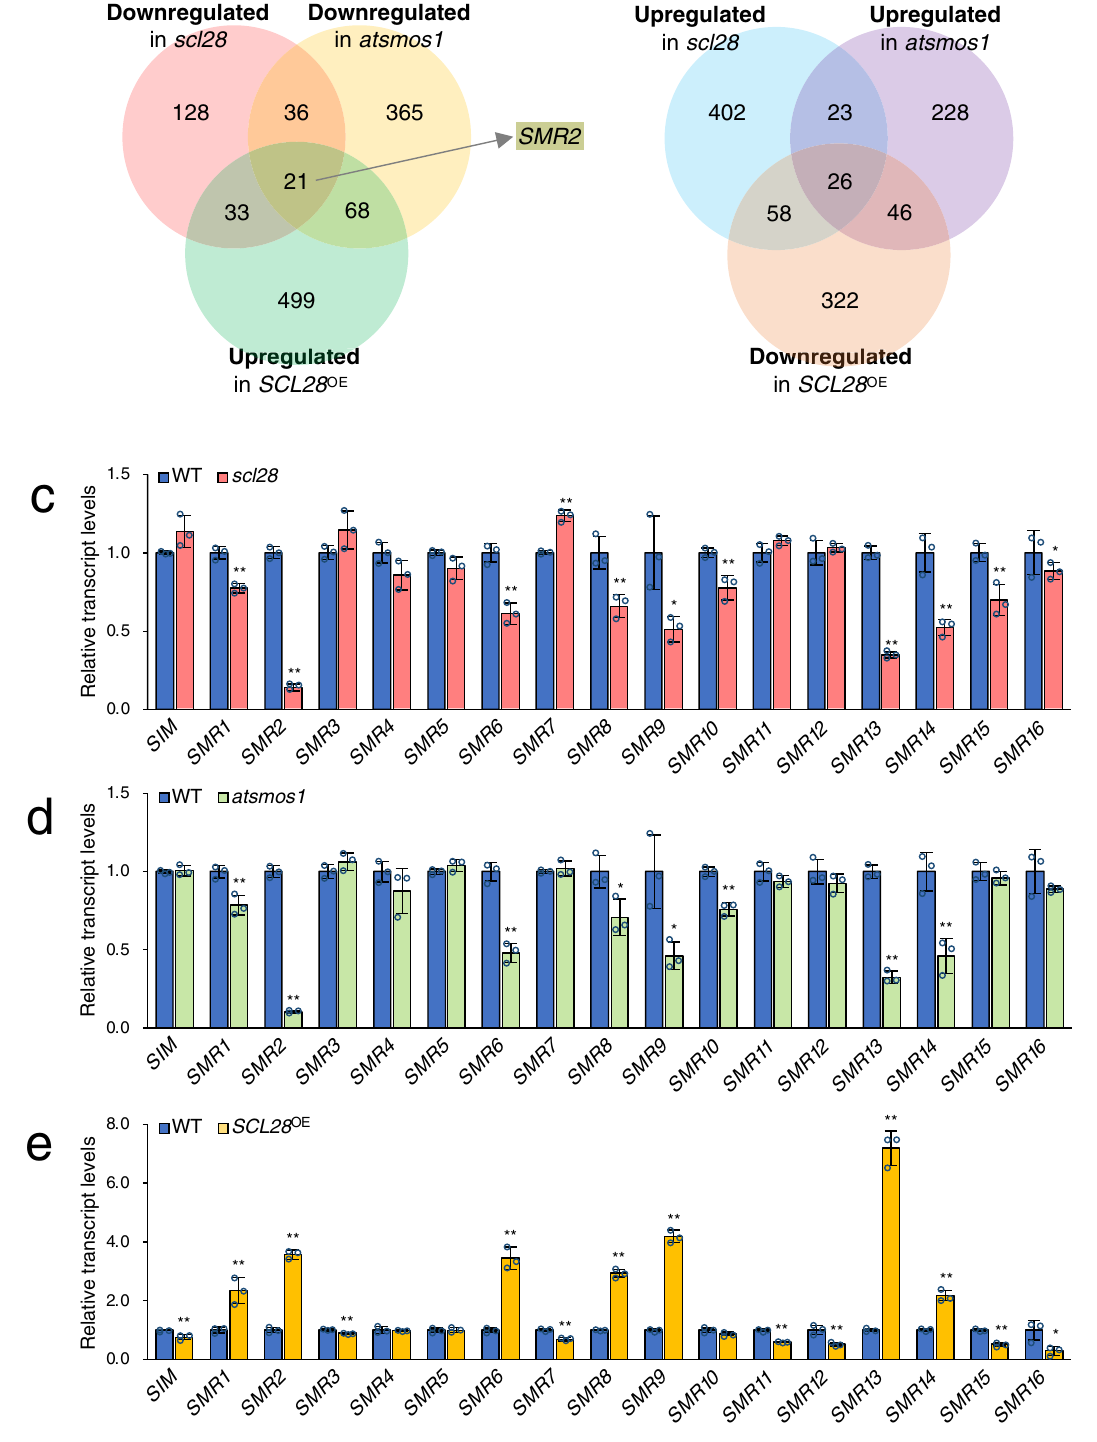
Fig. 5 SCL28 and AtSMOS1 activate transcription of SMR genes. a Venn diagram representing overlap between genes downregulated in scl28 and atsmos1 , and upregulated in SCL28 OE plants. The SMR2 gene was found in the overlap of these three categories. Upregulated and downregulated genes were de fi ned by a criterion of false-discovery rate (FDR)-adjusted P value < 0.05, which was obtained from expression data of three biological replicates. b Venn diagram representing overlap between genes upregulated in scl28 and atsmos1 , and downregulated in SCL28 OE plants. Upregulated and downregulated genes were statistically de fi ned as in ( a ). c – e Transcript levels of SMR genes in scl28 ( c ), atsmos1 ( d ), and SCL28 OE ( e ) plants at 8 DAS. qRT- PCR analysis of all 17 genes in the SMR family was performed to compare expression levels with WT plants. Data are averages from three biological replicates (±SD). Statistical signi fi cance compared with WT was determined using two-sided Student ’ s t test. * P < 0.05, ** P <